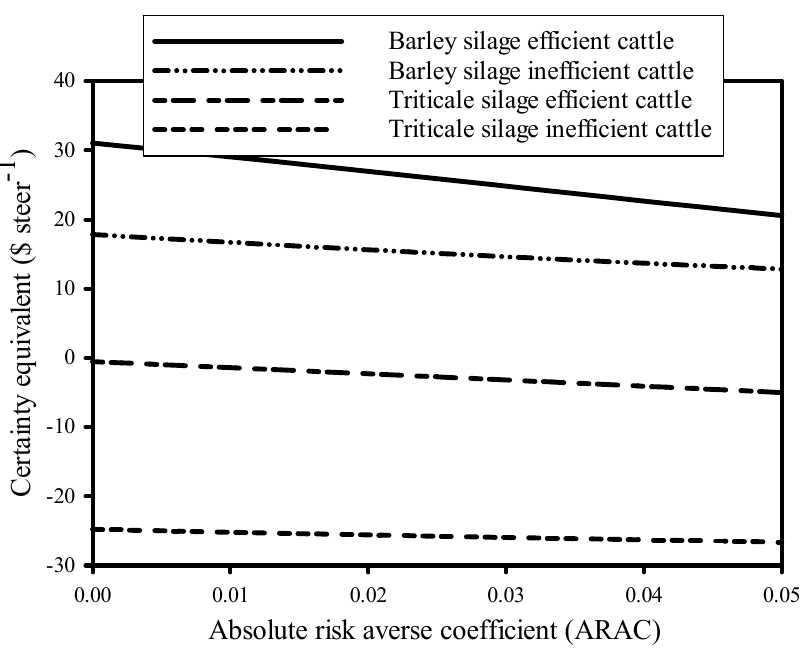
Figure 2. Comparison of certainty equivalent of barley and triticale silage-based diets and cattle efficiency type in beef backgrounding steers.